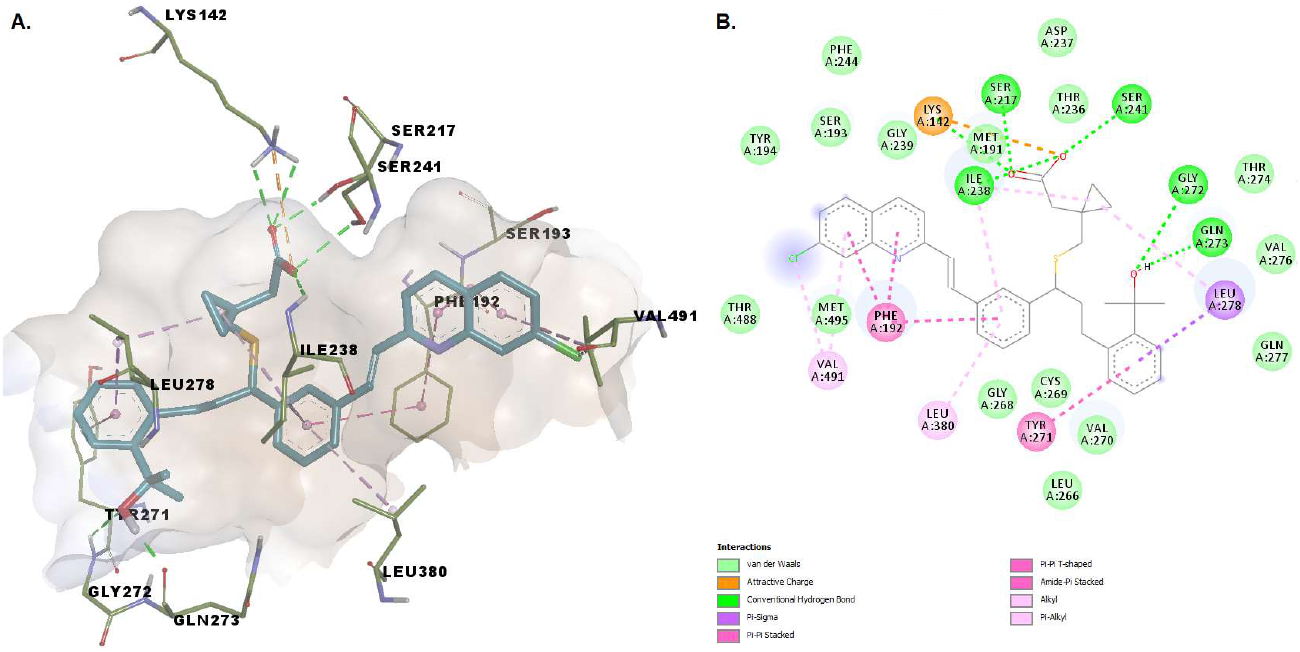
Figure 5. ( A ) 3D binding conformation of montelukast into FAAH binding site; ( B ) 2D diagram of protein-ligand interactions between FAAH and montelukast.